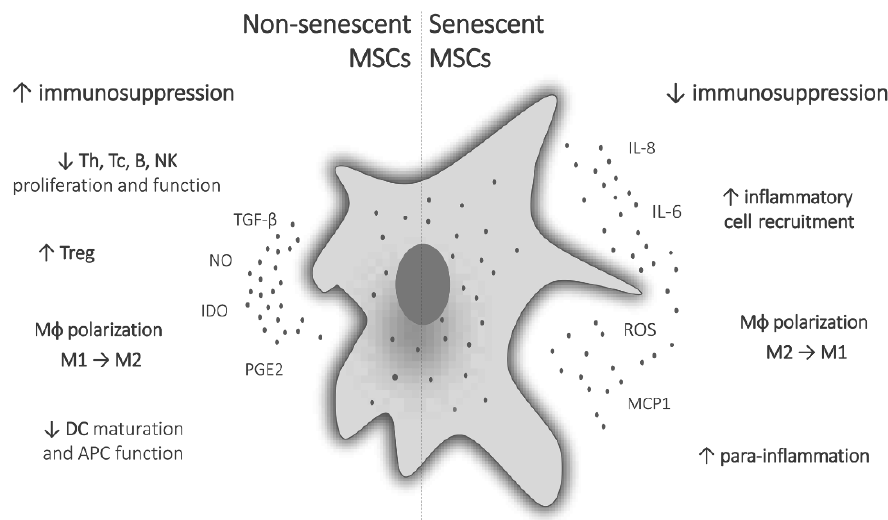
Figure 1. Immunomodulatory functions of non-senescent and senescent MSCs. Immunosuppressive functions of MSCs are expressed through the suppression of proliferation and function of T, B and NK cells, induction of regulatory T cells, polarization of macrophages to anti-inflammatory M2 phenotype, and suppression of DC maturation and antigen-presenting function. Senescent MSCs have reduced immunosuppressive potential, produce pro-inflammatory mediators, recruit inflammatory cells, polarize macrophages to inflammatory M1 phenotype, and lead to systemic low-grade para-inflammation.